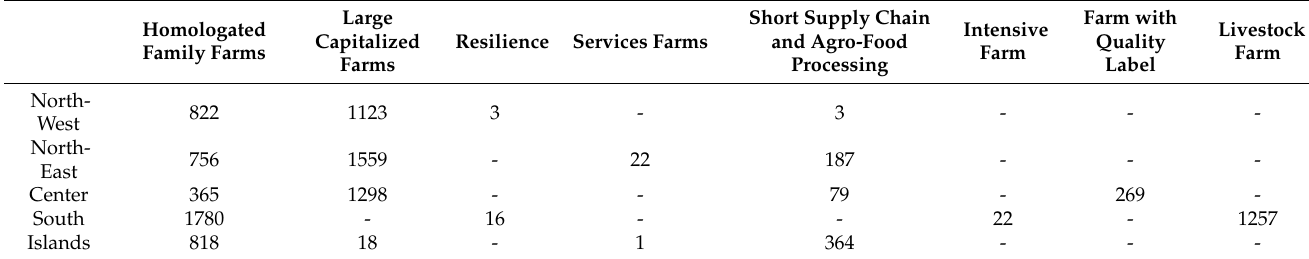
Table 3. Number of farms in each cluster by geographical